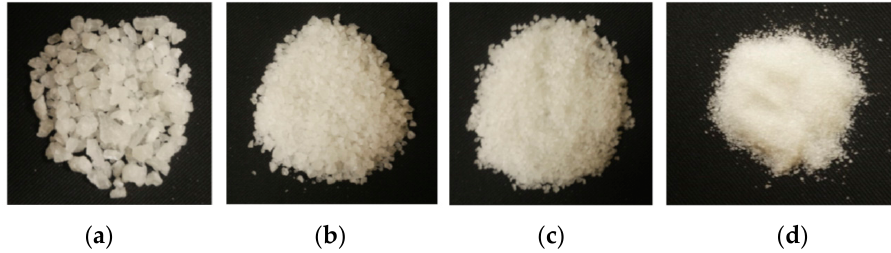
Figure 3. Sodium chloride particle sizes for the production of aluminium porous materials ( a ): 8 to 10 mm; ( b ): 5 to 7 mm; ( c ): 3 to 5 mm; ( d ): 1 to 3 mm.